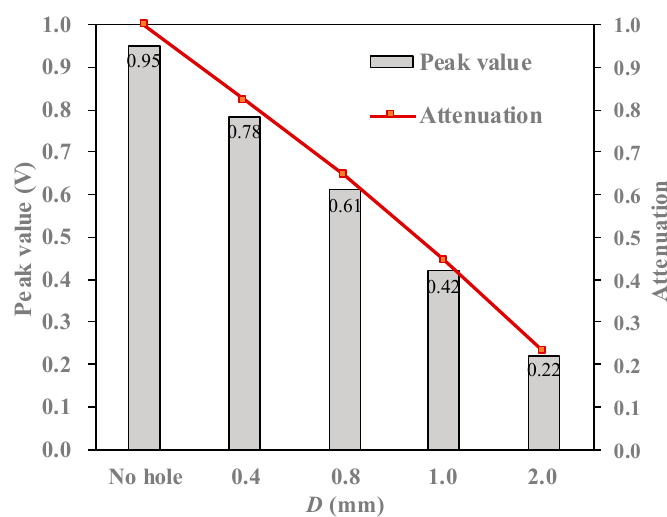
Figure 5. Peak value and attenuation of Rayleigh (R) wave at different hole diameters. Appl. Sci. 2020 , 10 , x FOR PEER REVIEW